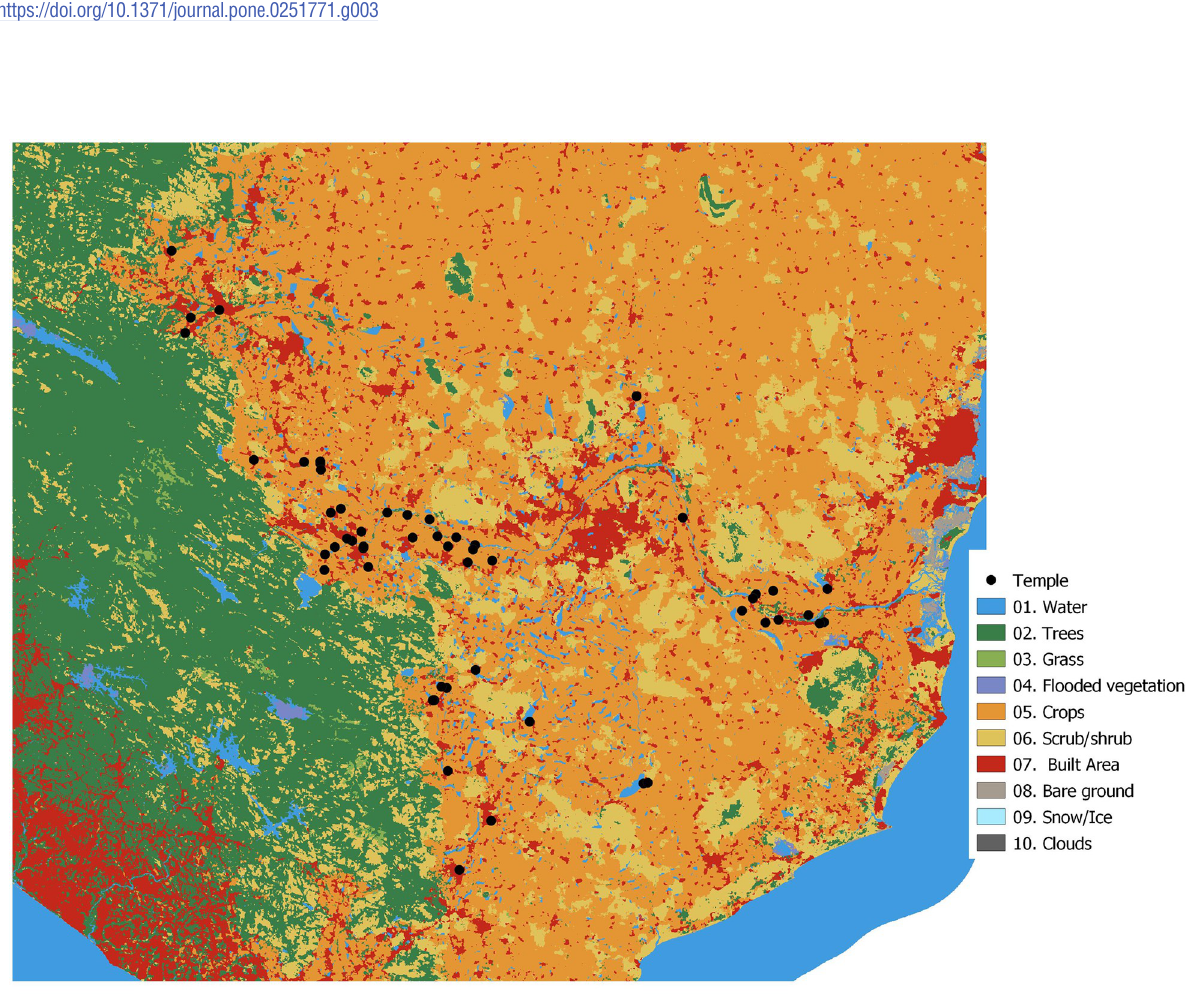
Fig 4. High resolution (10m) land-use around the temples sampled. Land use classification is based on Karra et al. 2021. See data analysis for more details.